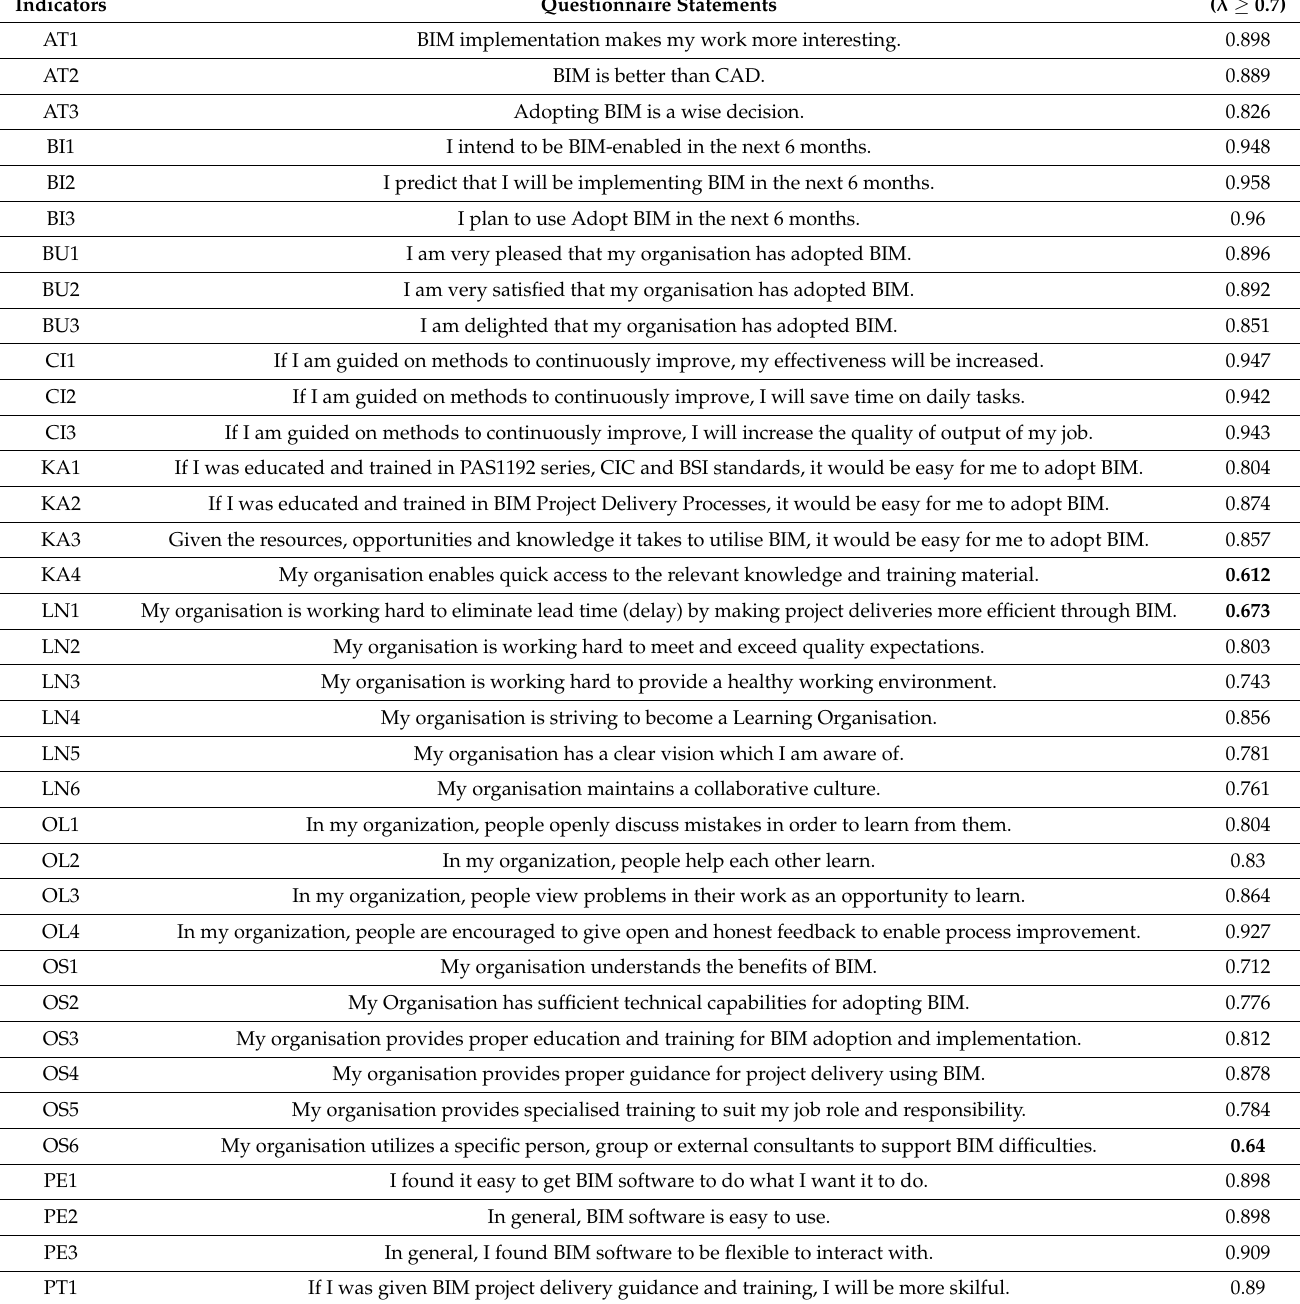
Table 2. Questionnaire statements and outer loading